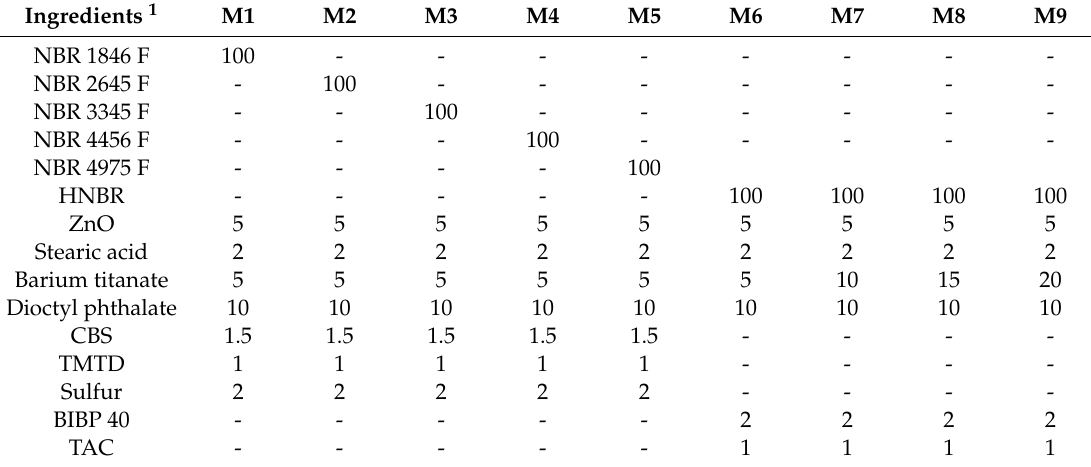
Table 1. Composition of various acrylonitrile butadiene rubber (NBR)-based DEs (in phr).